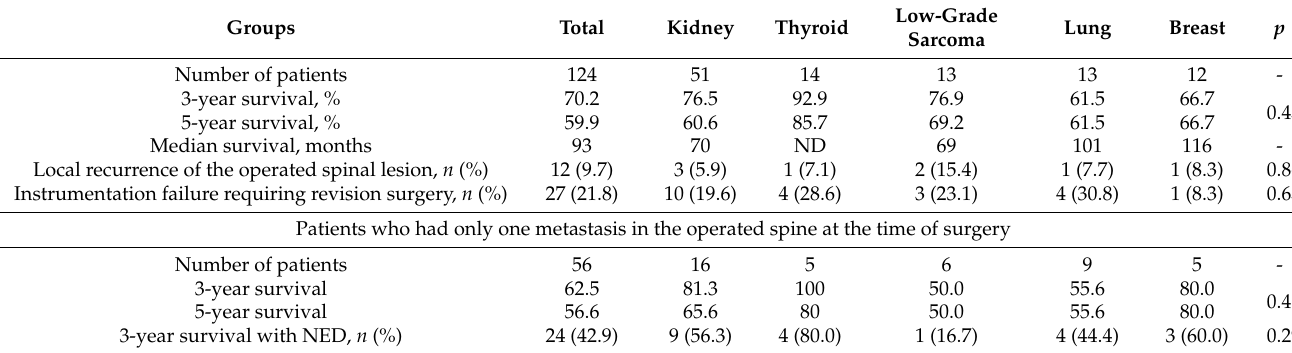
Table 2. Medium to long-term clinical outcomes of spinal metastasectomy.